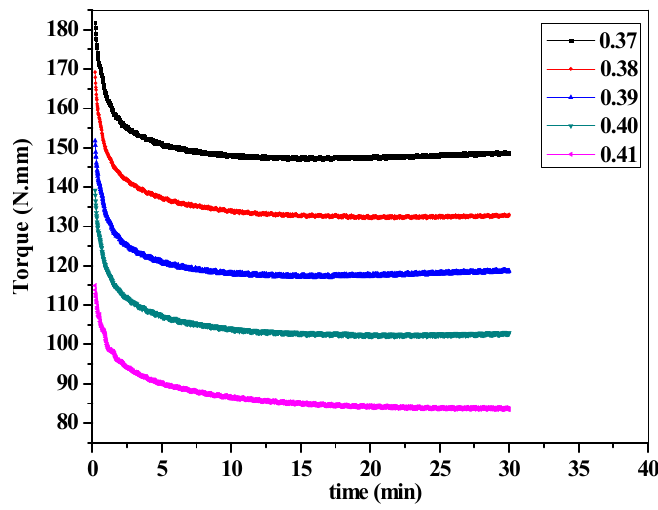
Figure 3. Torque versus time.